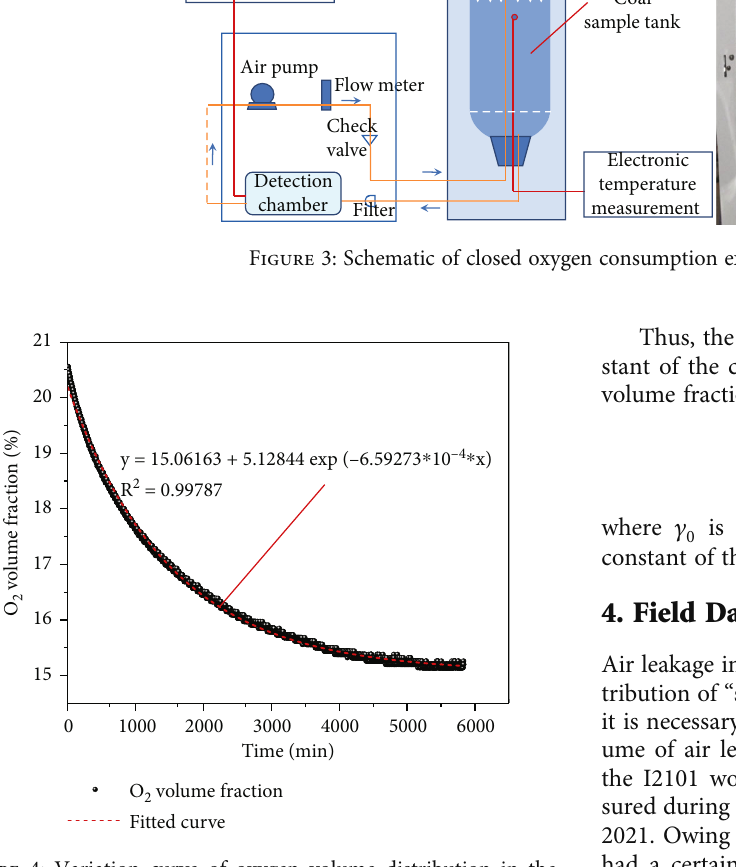
Figure 4: Variation curve of oxygen volume distribution in the experimental